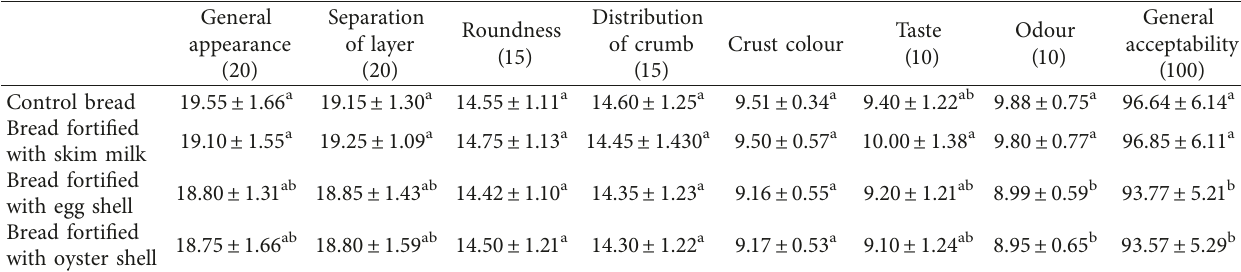
Table 4: Sensory evaluation of breads fortified with skim milk and egg shell and oyster shell